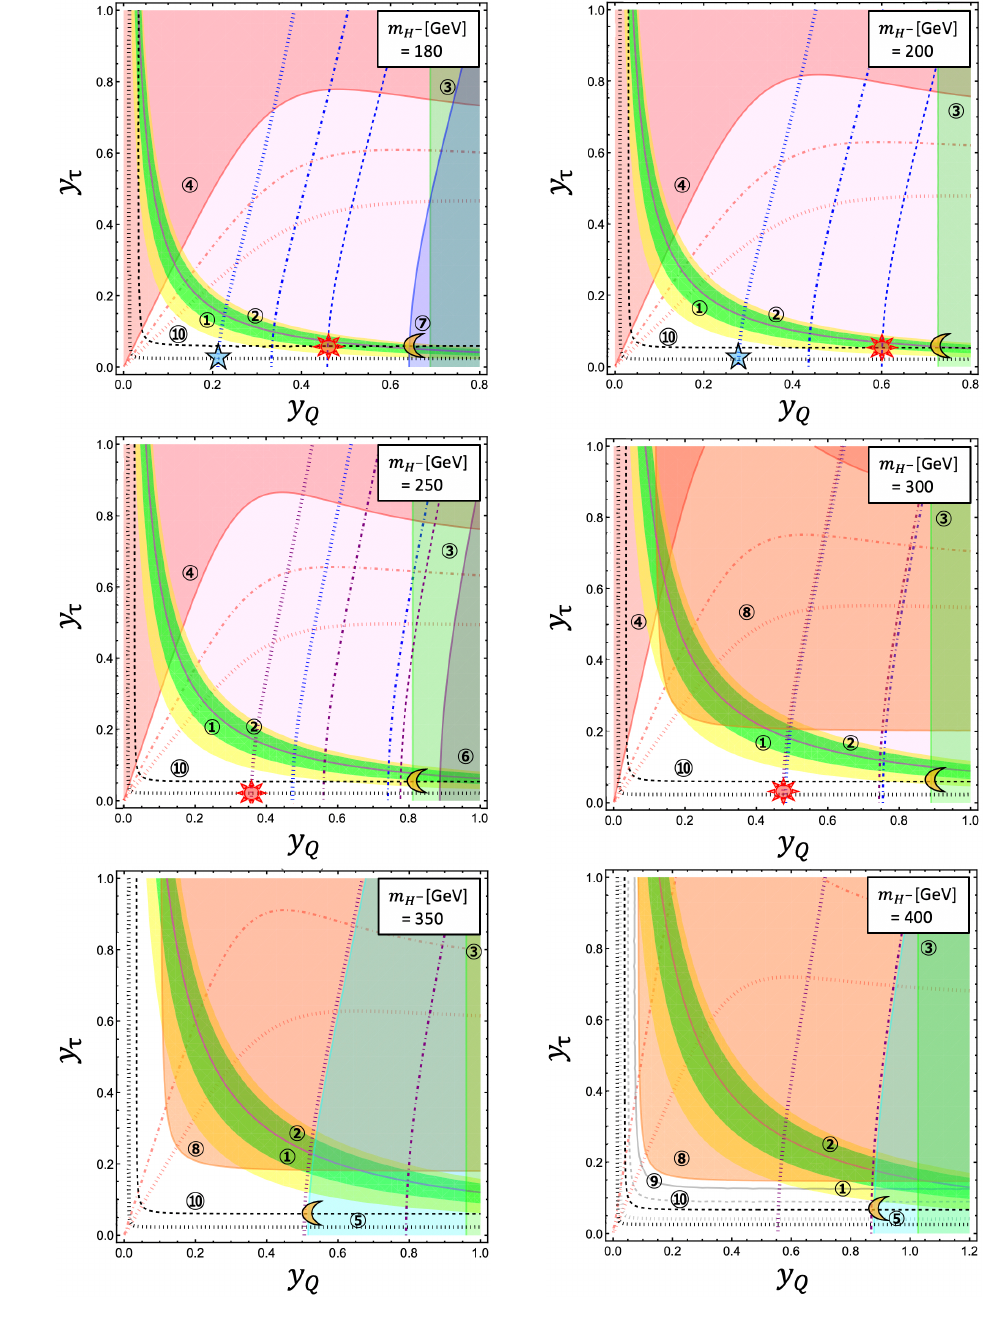
Figure 4 . The sensitivity of the bτν search channel is shown by dashed black lines in the ( y Q , y τ ) coupling plane. The charged Higgs mass is fixed to be 180 , 200 , 250 , 300 , 350 , and 400 GeV, as shown in the upper right corner of the respective panel. In each panel we define benchmark points denoted by a crescent moon, sun and star. The numerical values of the corresponding couplings can be found in the main text. Other flavor and collider constraints are also shown. The circled numbers express the relevant observables and processes defined in table 2. Solid lines show the current constraint while dashed, dotted-dashed, dotted lines correspond to the projected sensitivity with 139 fb − 1 , 500 fb − 1 , and 3 ab − 1